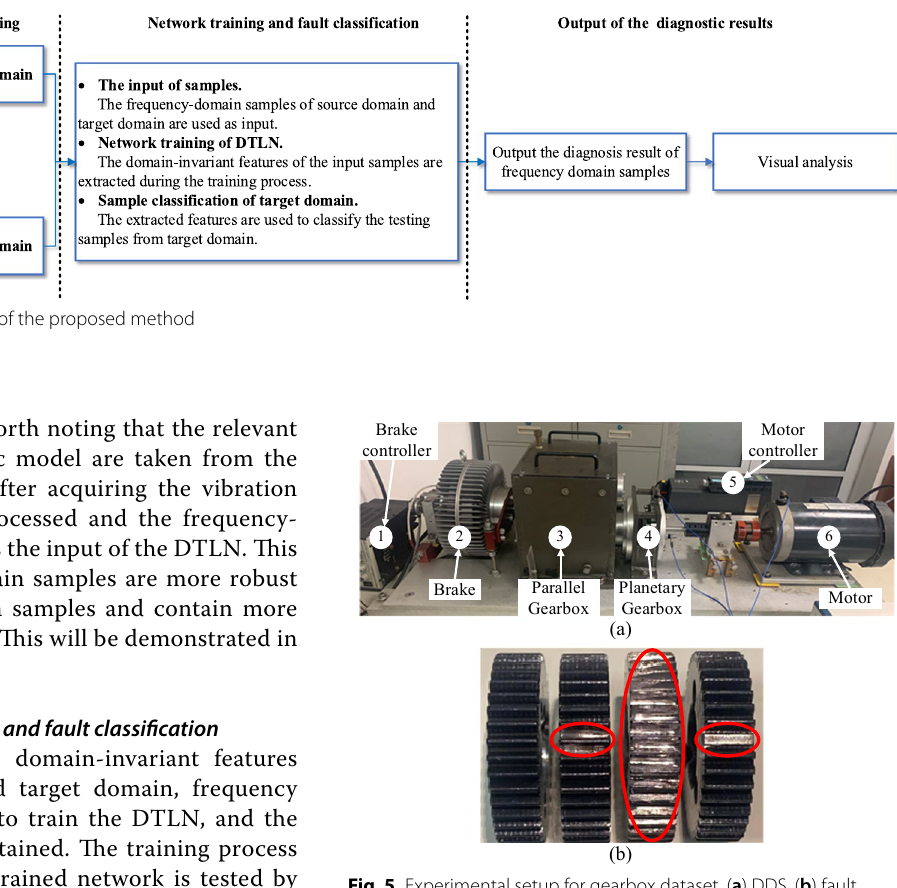
Fig. 5 Experimental setup for gearbox dataset. ( a ) DDS. ( b ) fault gears